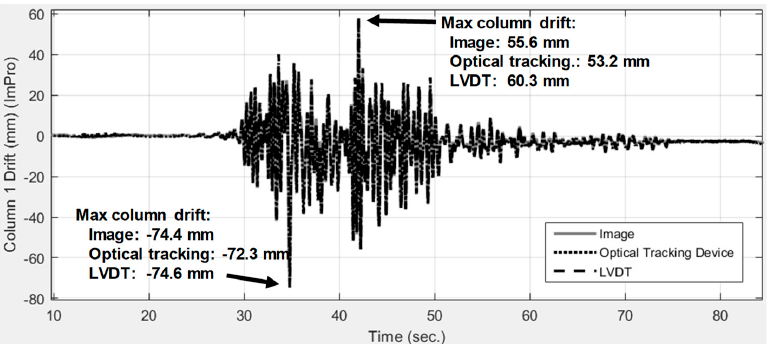
Figure 17. Comparison of three different measurement system results for first-story drift history. Image analysis gives satisfactory accuracy comparing with other sensors.